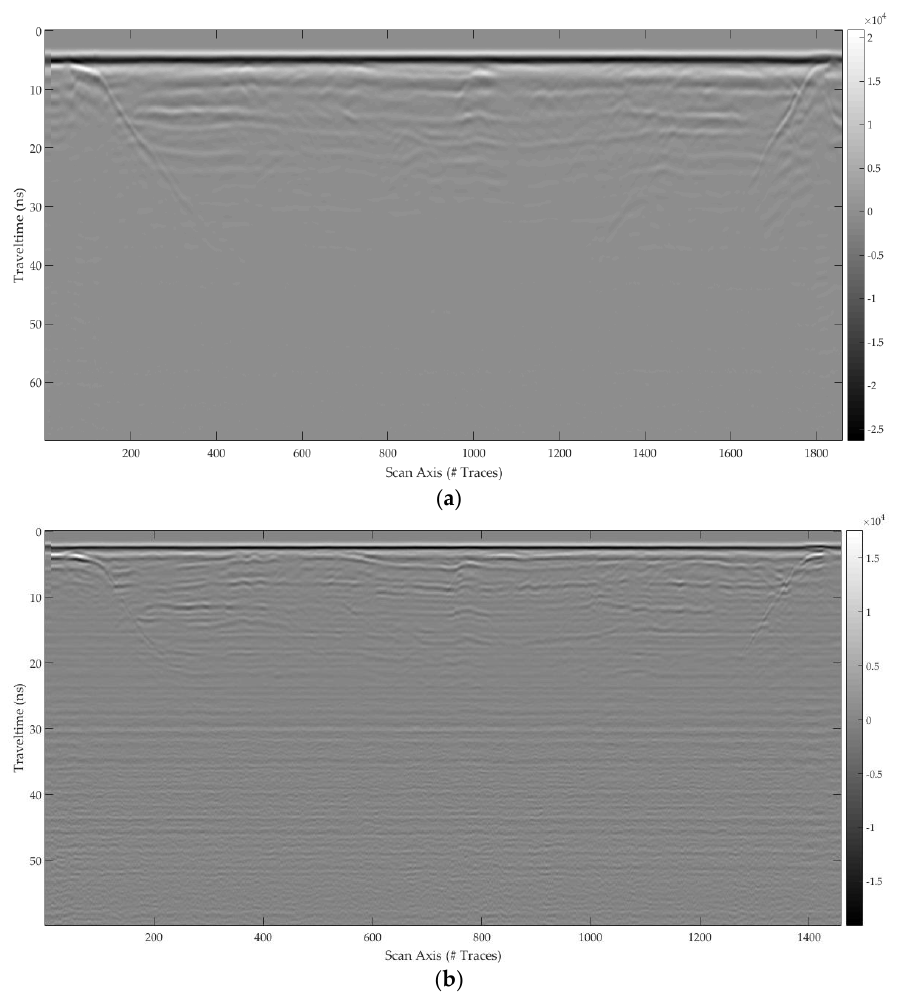
Figure 40. Profiles recorded in the Gneiss 0/20 gravel region by using GPR 1, on acquisition line 2, with antennas operating at: ( a ) 400 MHz; ( b ) 900 MHz.